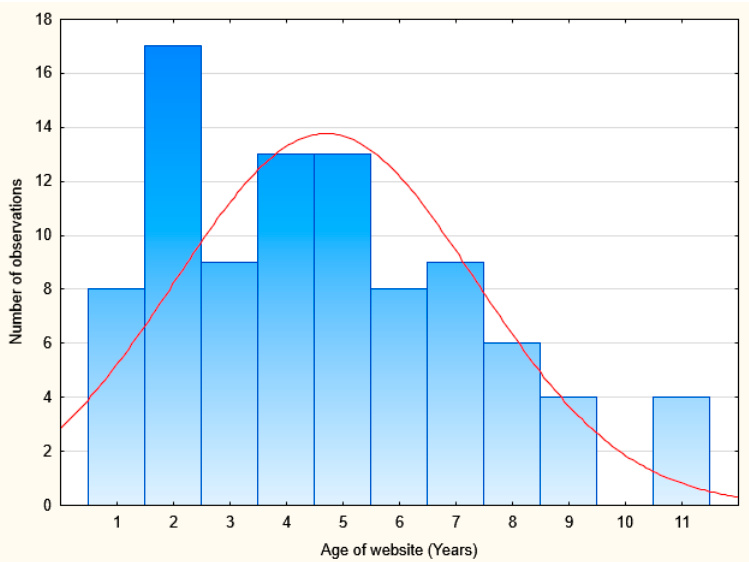
Figure 3. The age of hospital’s websites. Source: Original work based on the Internet Archive. Table 4. “Mobile friendly” test results.